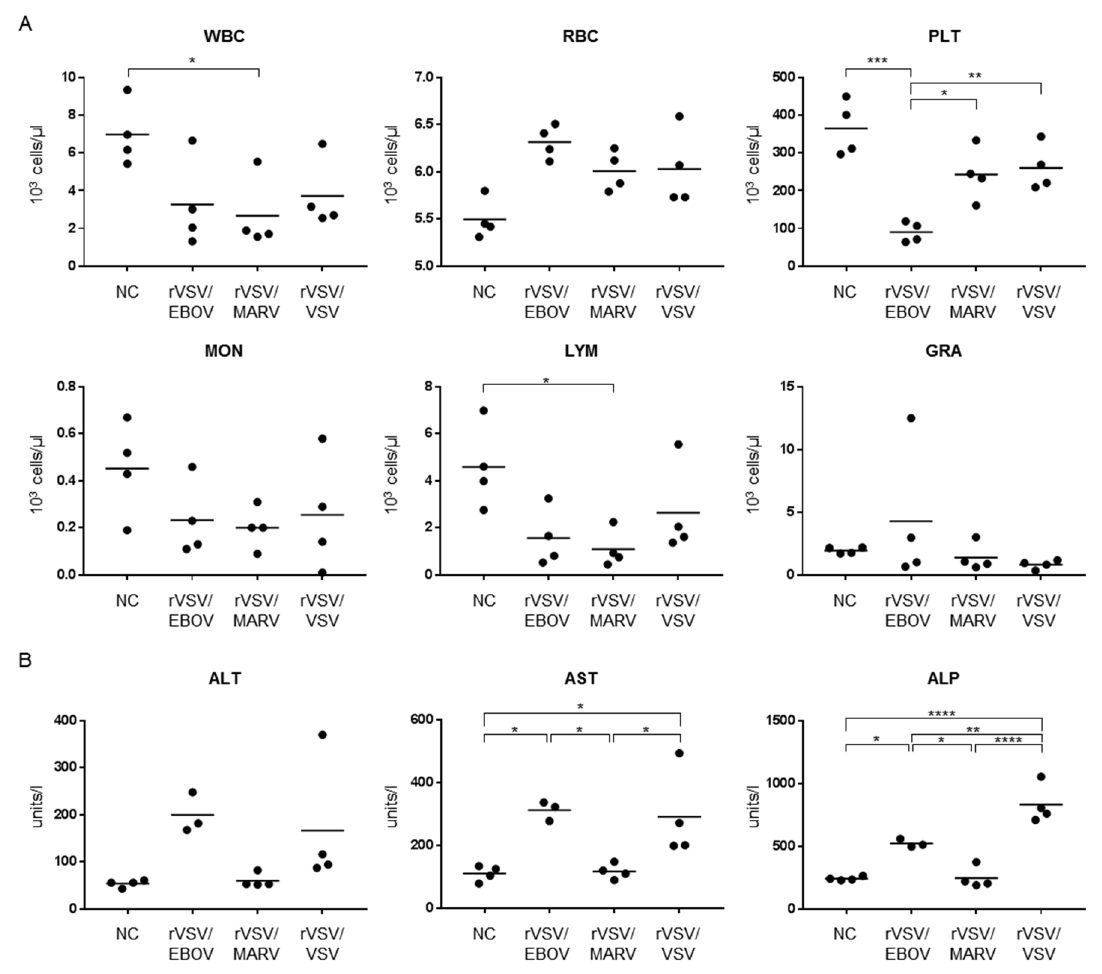
Figure 5. ( A ) Blood cell counts and ( B ) liver parameters in hamsters infected with rVSVs. Four hamsters in each group were infected i.p. with 10 7 PFU of rVSV / EBOV, rVSV / MARV, or rVSV / VSV. Twelve hours after virus inoculation, blood and serum samples were collected and used for cell counts and blood biochemistry. Each symbol represents the value for an individual hamster. The bars represent the means of the infected hamsters. * p < 0.05, ** p < 0.005, *** p < 0.0005, **** p < 0.00005.